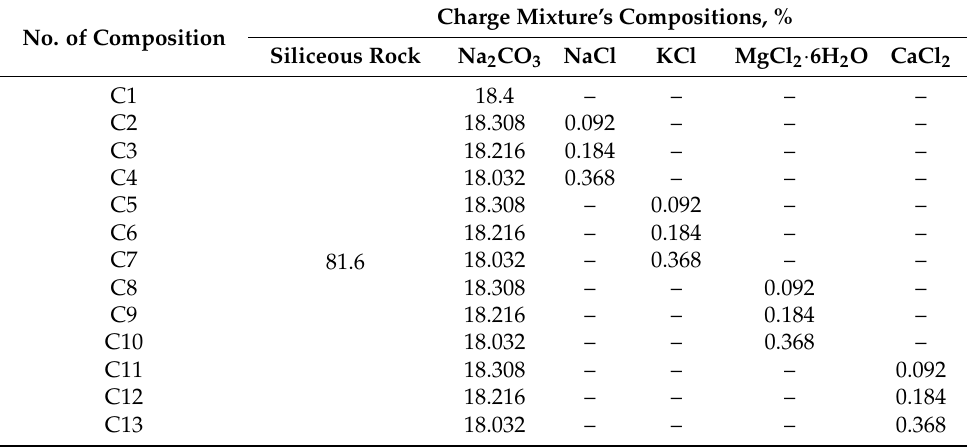
Table 1. Charge mixture’s